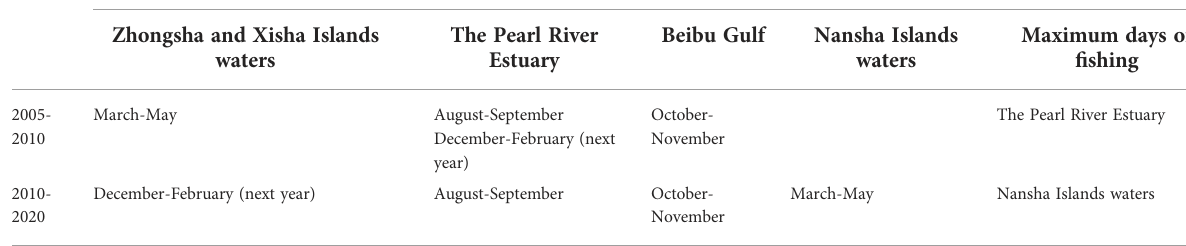
TABLE 2 A comparison of fi shing area for large-size light falling-net vessels in the South China Sea.